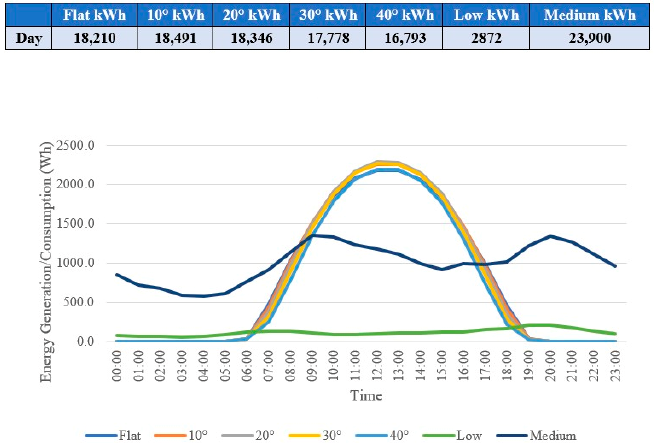
Figure 8. Comparison between hourly electricity generation of a 3 kWp PV system and the patterns of low-, and medium-consumption households for a south-facing system in May.